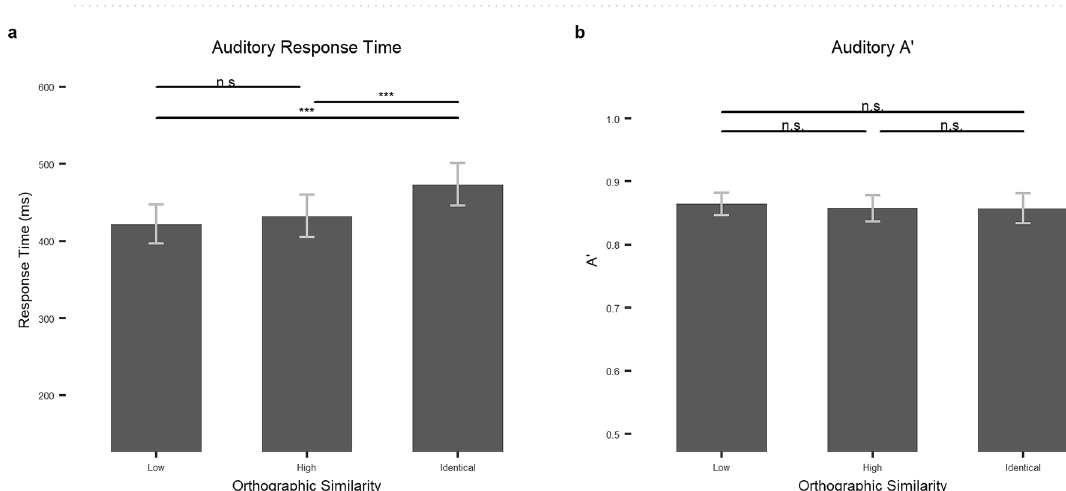
Figure 2. Results for the lexical decision task in the auditory modality. ( a ) Response times in miliseconds and ( b ) A’ by phonological (bar clusters) and orthographic (bar color) similarity for the auditory task. Error bars stand for 95% confidence intervals.